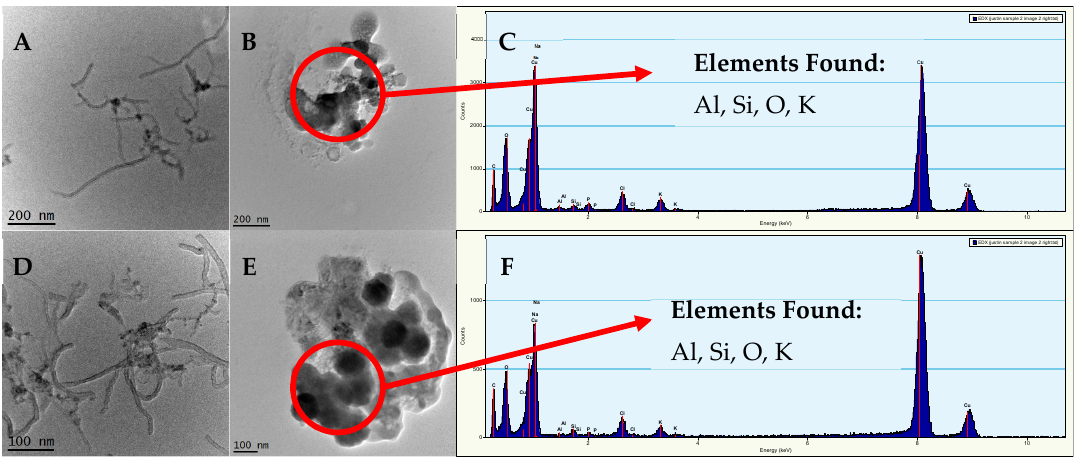
Figure 4. ( A ) TEM image of MWCNT in 1 mM NaHCO 3 matrix solution after initial spike ( < 1 h), ( B ) TEM image of MWCNT in 2% HNO 3 matrix solution after initial spike ( < 1 h), ( C ) EDAX of MWCNT from image B, ( D ) TEM image of MWCNT in 1 mM NaHCO 3 matrix solution after 24 h, ( E ) TEM image of MWCNT in 2% HNO 3 matrix solution after 24 h, ( F ) EDAX of MWCNT from Image E.